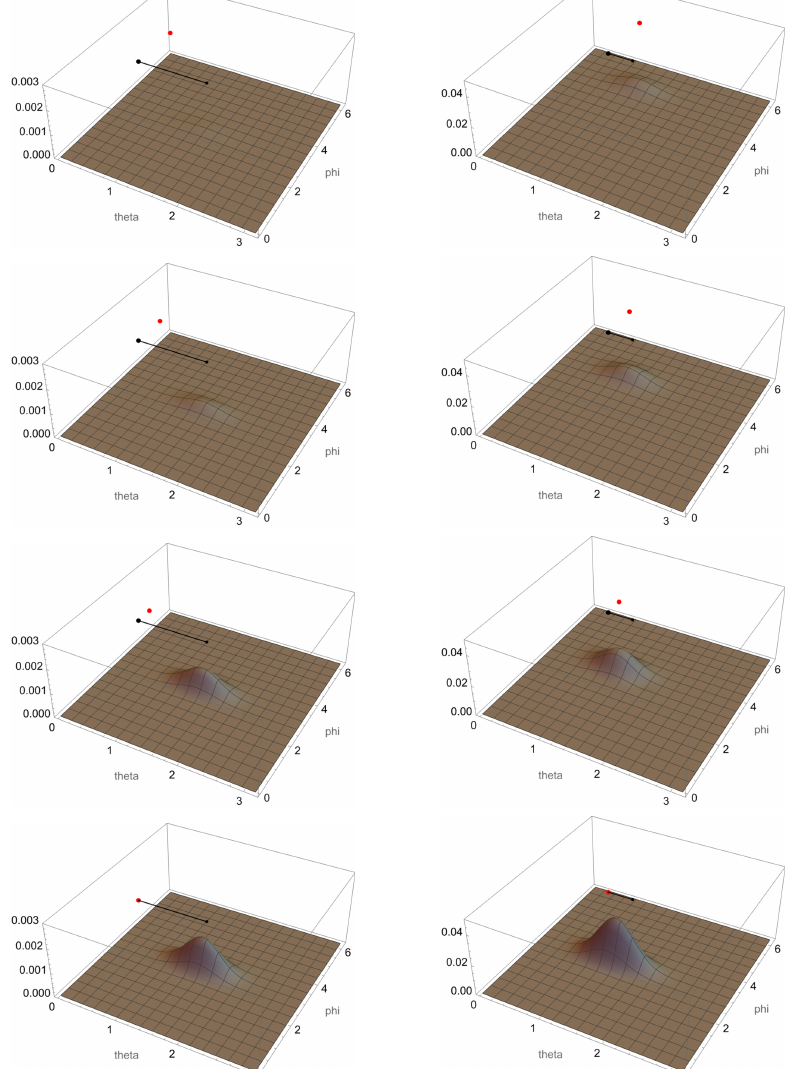
(cid:12) (cid:1) x , the upper label x by the larger dot. (cid:12) y (cid:12) (cid:1) x 0 . The two (cid:12) y 0